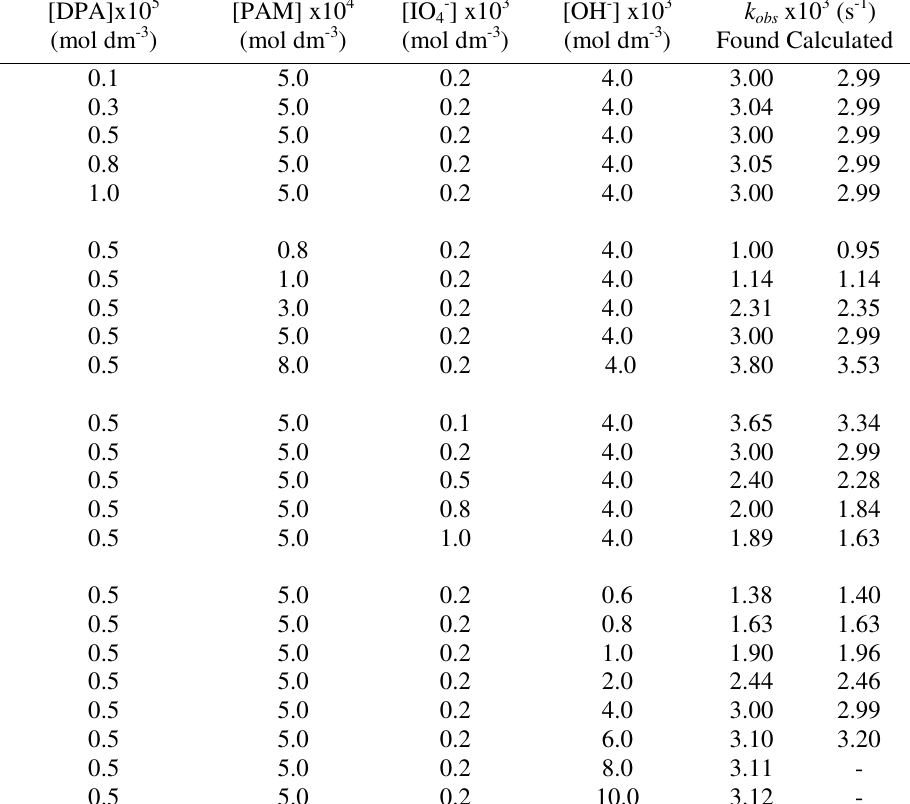
Table 1 . Effect of [DPA], [PAM], [IO 4- ] and [OH - ] on diperiodatoargentate (III) oxidation of paracetamol in alkaline medium at 25 0 C, I = 0.01 mol dm -3